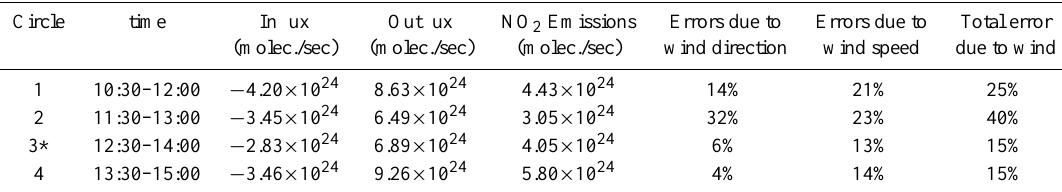
Fig. 5. NO 2 VCDs for the four individual cycles around the Mannheim-Ludwigshafen area on 24 August 2006. The letters “N”, “M”, and “S” indicate the locations of the in-situ measurement stations Mannheim North, Mannheim Center, and Mannheim South. Arrows indicate the average wind direction. Table 2. Total NO 2 fluxes for the different circles. Also shown are the relative errors related to variations and imperfect knowledge of the wind